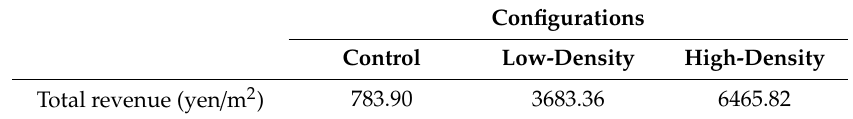
Table 8. Annual total revenue per square meter from corn crops and PV in di ff erent configurations.